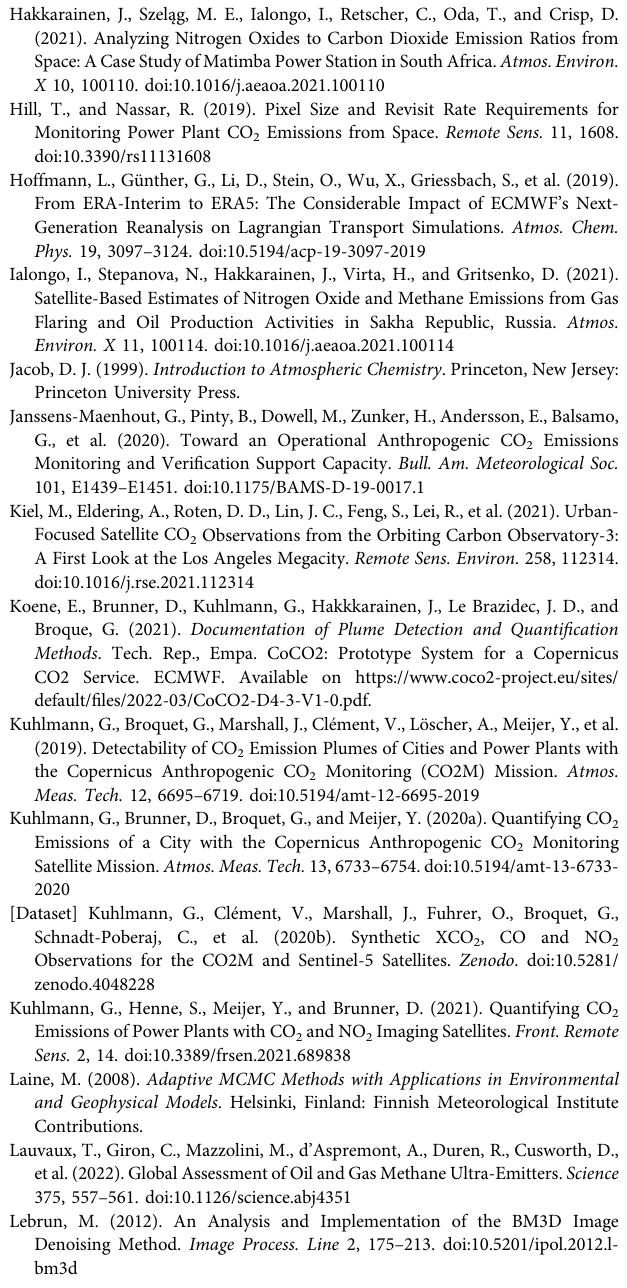
Algorithm. Bernoulli 7, 223. doi:10.2307/3318737 Hakkarainen, J., Ialongo, I., Maksyutov, S., and Crisp, D. (2019). Analysis of